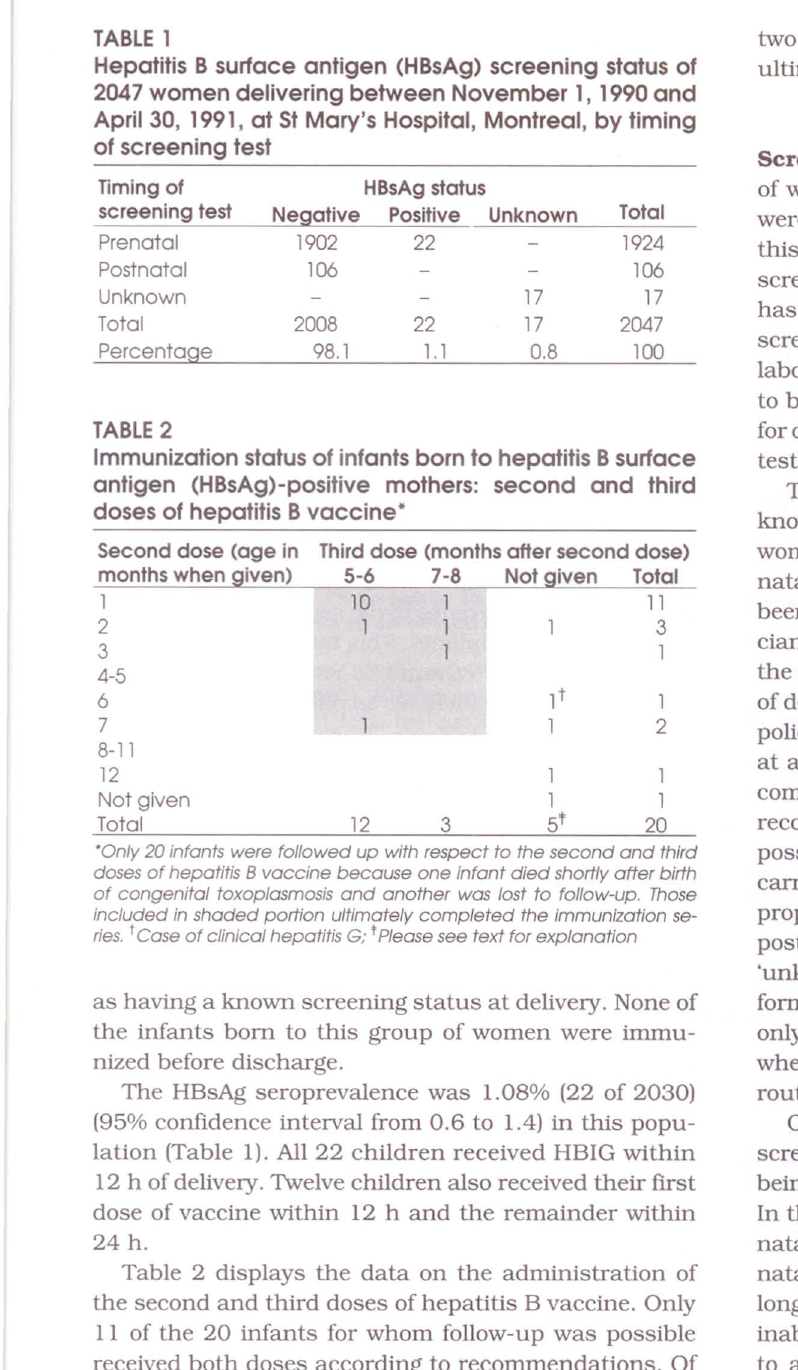
Immunization status of infants born to hepatitis B surface antigen (HBsAg)-positive mothers: second and